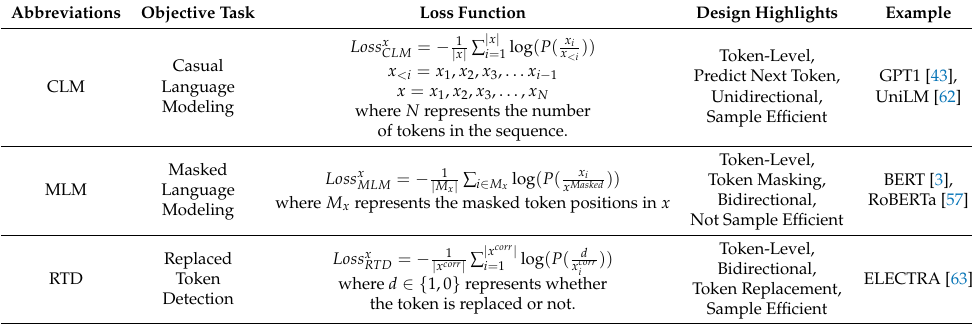
Table 2. List of pre-training objectives tasks and their corresponding loss functions definition, along with the list of example TB models that used this pre-training